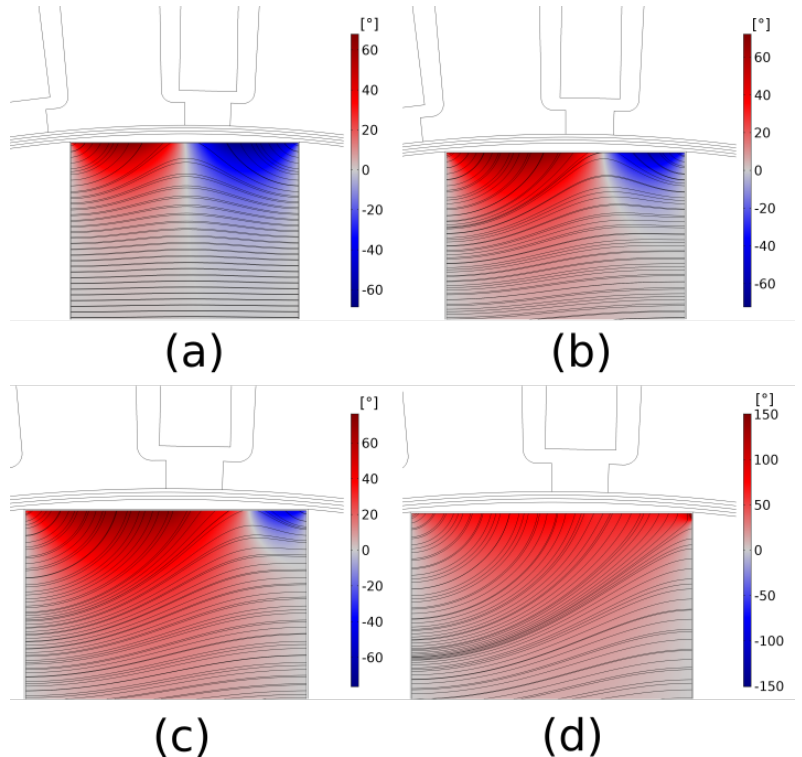
Figure 5. Inclination angle of the magnetic field strength, H , for different current densities. The current densities J rms in ( a – d ) is 0 A/mm 2 , 2 A/mm 2 , 3.5 A/mm 2 and 5 A/mm 2 ,